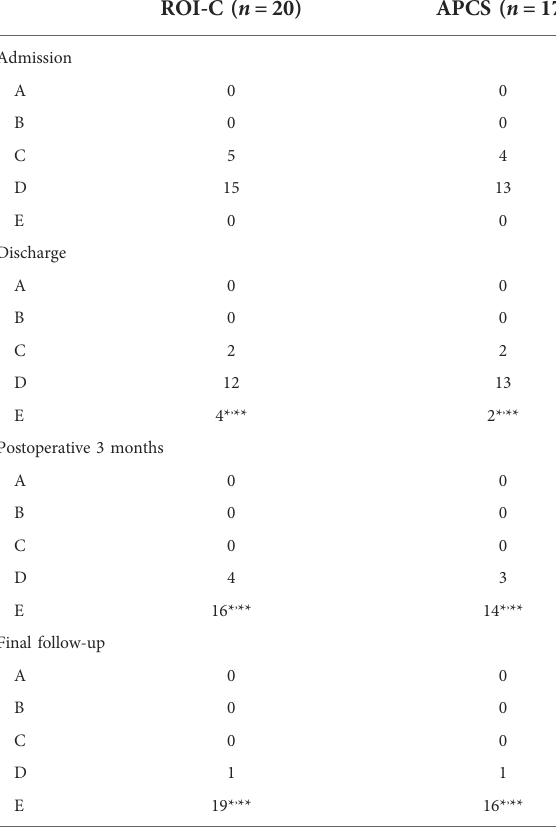
TABLE 3 ASIA grading for neurological